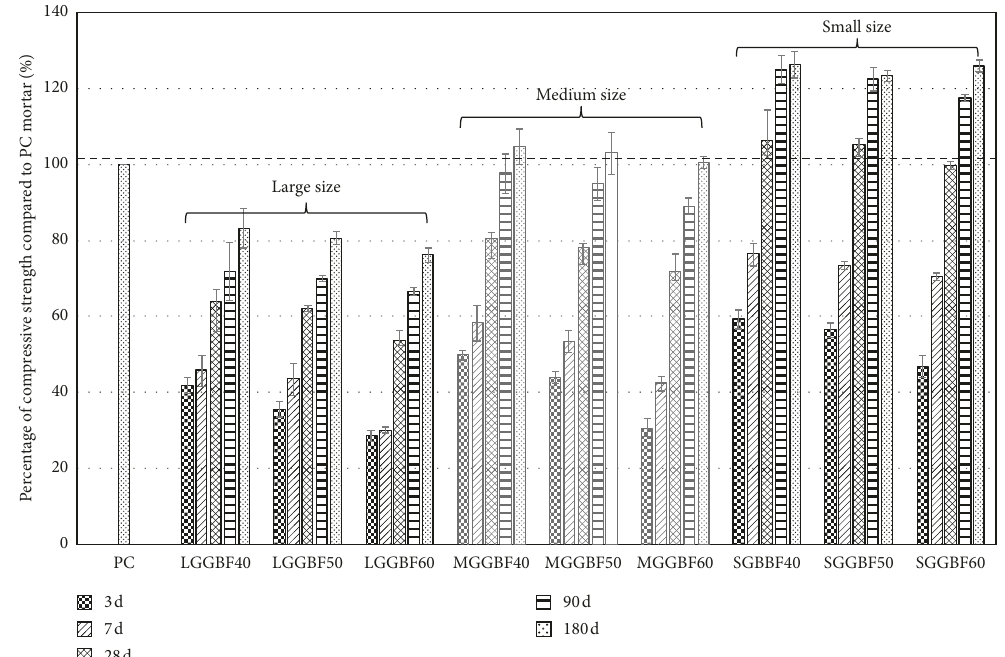
Figure 7: Percentage of compressive strength of GGBF mortar and the replacement of PC by the GGBF slag with different particle sizes. Table 7: Compressive strengths of GGBF slag mortars obtained from the slag reaction. Mixtures Compared